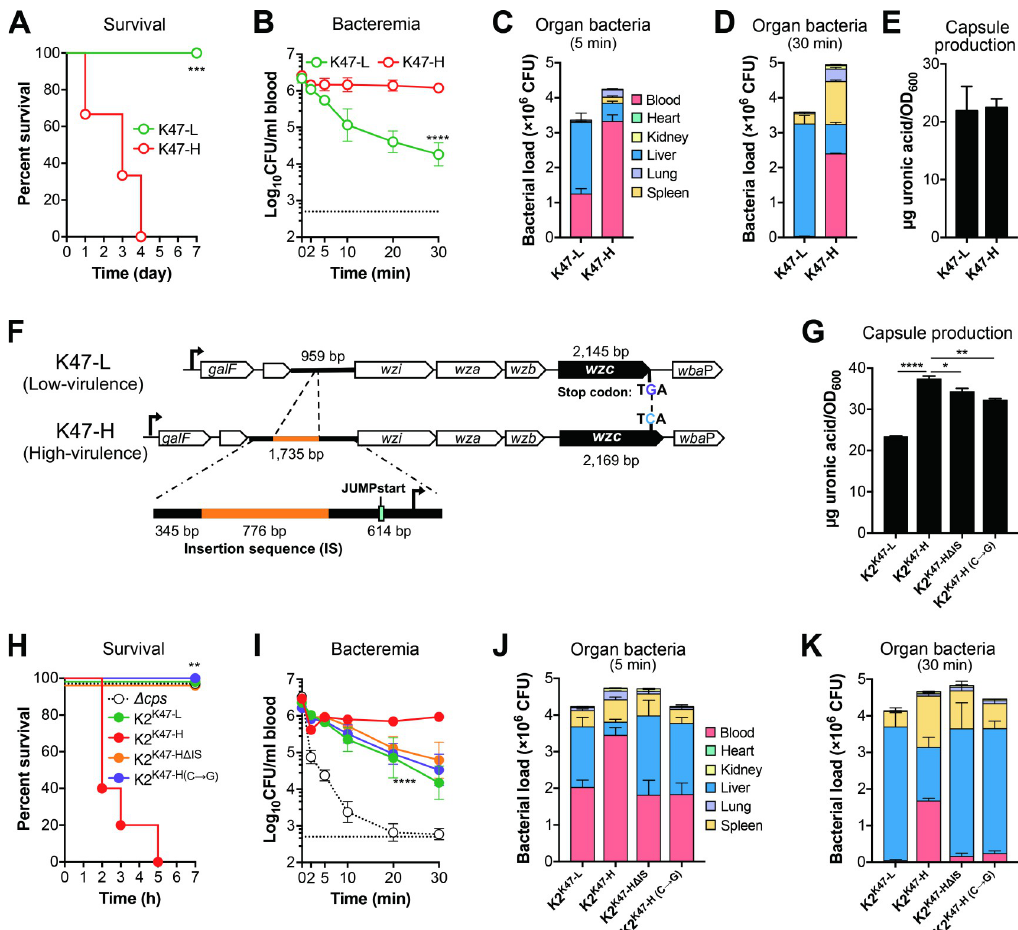
Fig 7. Variation in virulence among type K47 strains. A. Virulence of capsule type-K47 HV and LV strains. CD1 mice were i. p. infected with 10 6 CFU of high-virulence TH12845 (K47-H) or low-virulence strain TH12846 (K47-L). Mortality was assessed in a 7-day period. n = 6. B-D. Difference of HV and LV K47 strains in resisting hepatic capture. CD1 mice were i.v. infected with 5 × 10 6 CFU of K47-H and K47-L to determine bacteria in the bloodstream ( B ) and major organs at 5 min ( C ) and 30 min ( D ). n = 4. E. Capsule production of K47-H and K47-L. K47 CPS was quantified as in Fig 2D. F. Schematic illustration of sequence difference in the K47 cps locus between K47-H and K47-L. The DNA sequences between the galF and wbaP genes of the K47 cps locus of K47-H and K47-L are drawn to show the two sequence differences between the two strains. The coding sequences are identified with gene names. The 776-bp insertion sequence upstream of wzi in K47-H is marked with a yellow line; the C-G SNP at the 2144 th nucleotide of the wzc coding region in K47-L indicated with a vertical dashed line between the two sequences; putative promoter and JUMPstart sequences marked with black arrow and indigo rectangle, respectively. G. Capsule production of K47 variants was quantified as in (E). H. Effects of the IS and wzc SNP on the virulence of K47 variants. Mice were infected with the K47 cps variants of ATCC43816 to determine survival rates as in (A). n = 5. I-K. Virulence traits of the K47 cps variants. Bacteremia kinetics ( I ) and bacterial load in major organs at 5 min ( J ) and 30 min ( K ) were determined in mice i.v. infected as in (B). All data are presented as mean ± SD. Log-rank test (A and G), two-way ANOVA with Tukey’s multiple comparisons test (B and I) and one-way ANOVA with Tukey’s multiple comparisons test (L) were performed. �� , P < 0.01; ��� , P < 0.001; ���� , P <